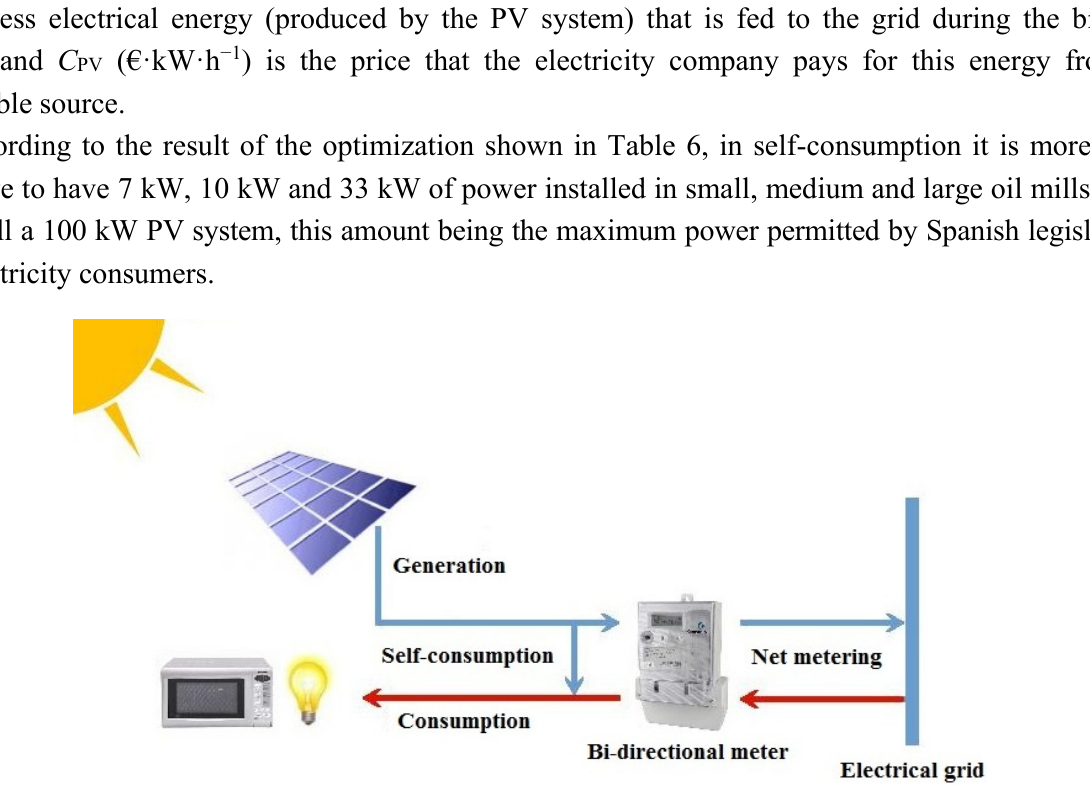
Figure 6. Scheme of grid-connected PV system and differences between self-consumption and net metering